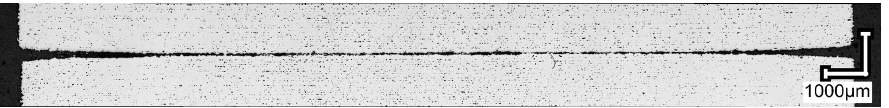
Figure 19. Sintered joint with macroscopic shape deviation.